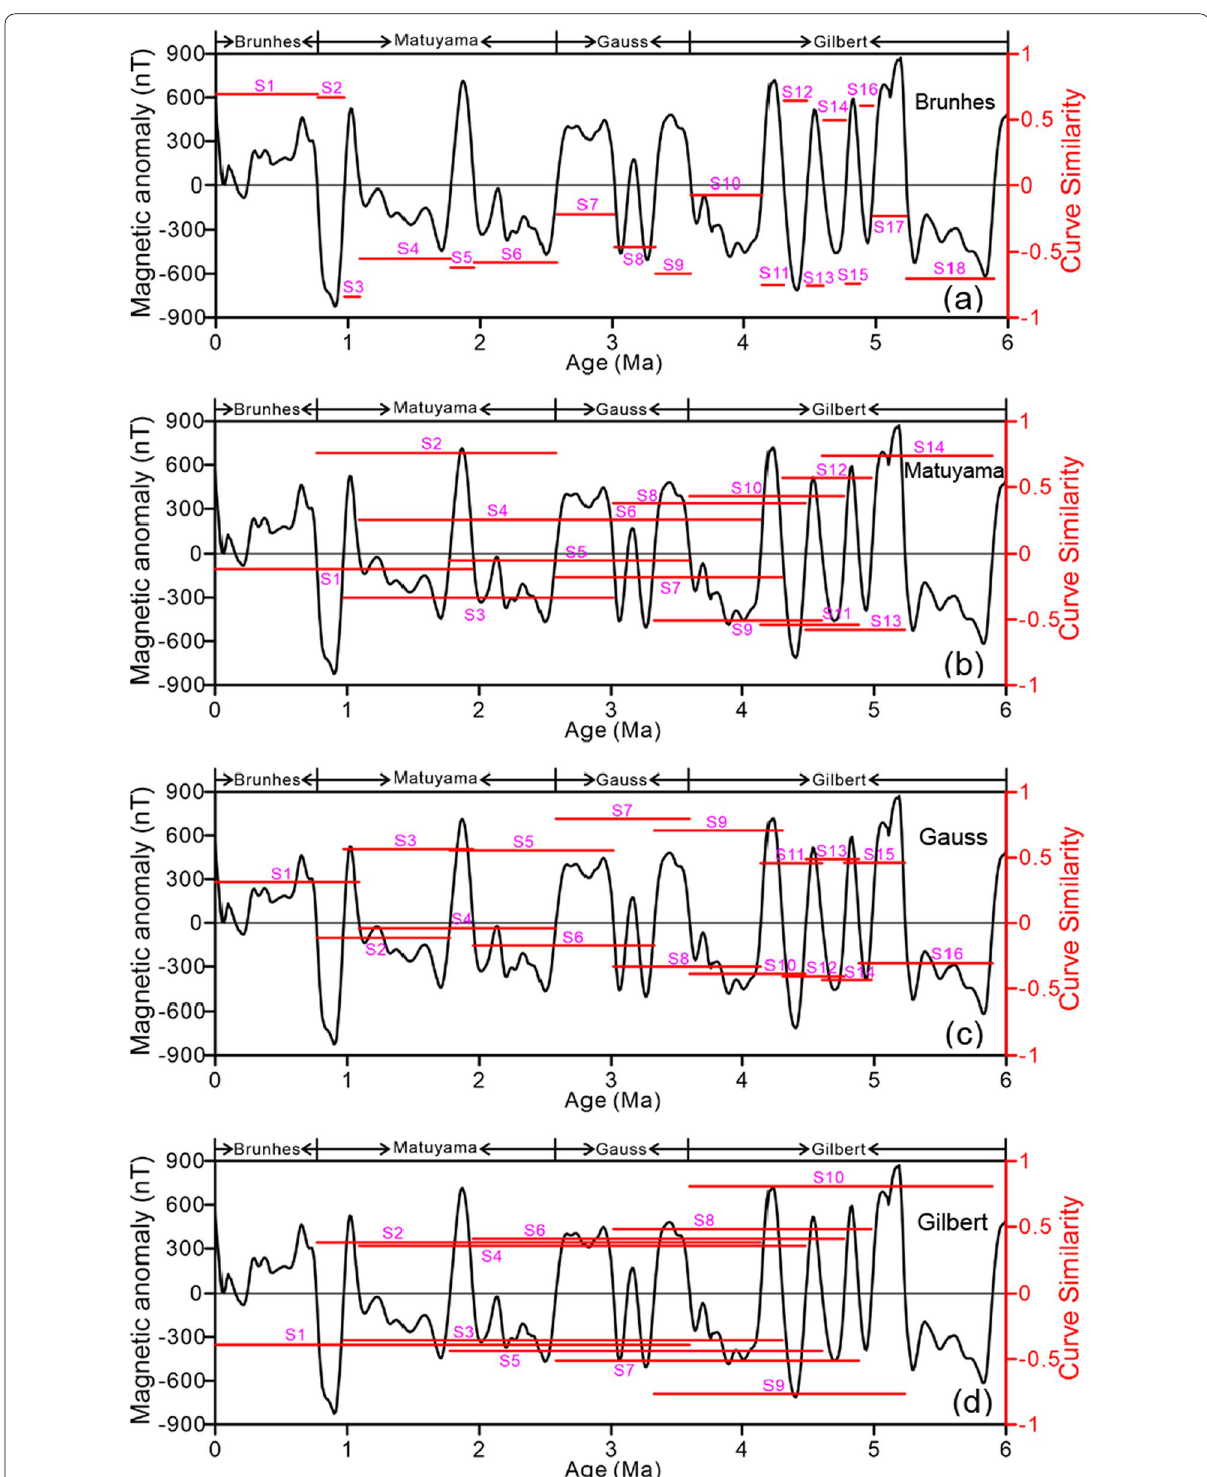
Fig. 17 The identification results of the magnetic anomalies of profile A1. a – d The identification results of the Brunhes, Matuyama, Gauss and Gilbert chrons, respectively. The red lines represent the values of the curve similarity in different steps (Magenta